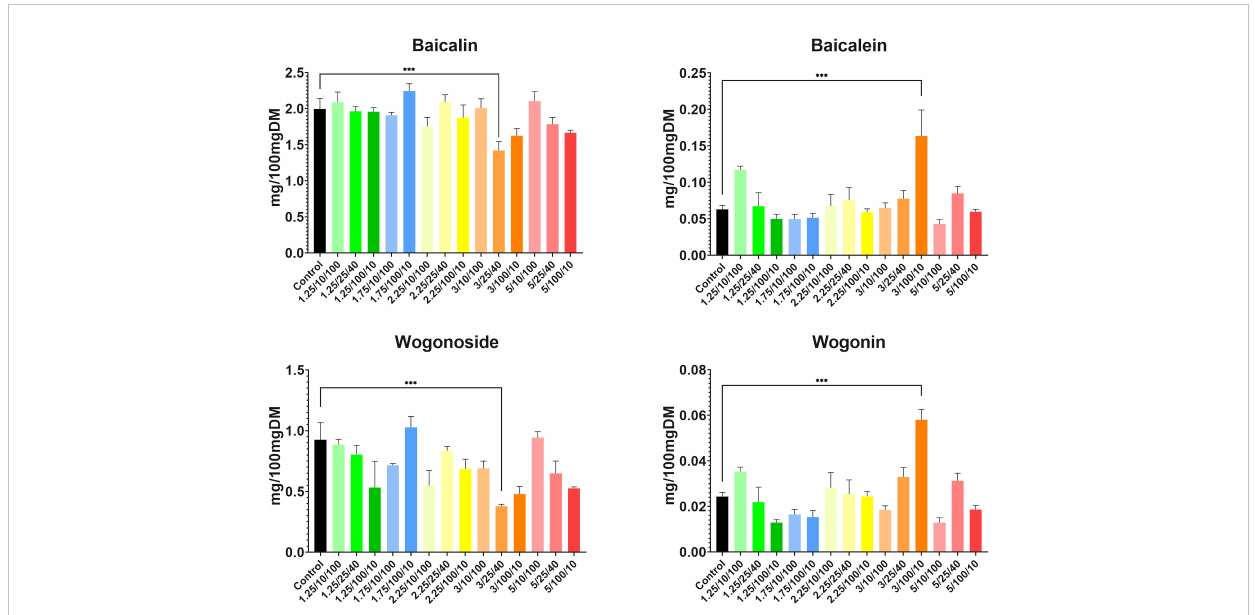
FIGURE 7 Concentrations of four main compounds of interest yielded from each subgroup with the largest statistical differences (*** indicates P<0.0001) between treated subgroups and controls, highlighted by asterisks found after conducting a two-way ANOVA analysis. Parameters shown on the X- axis are presented in the following order: E/t/N. DM stands for dried mass.